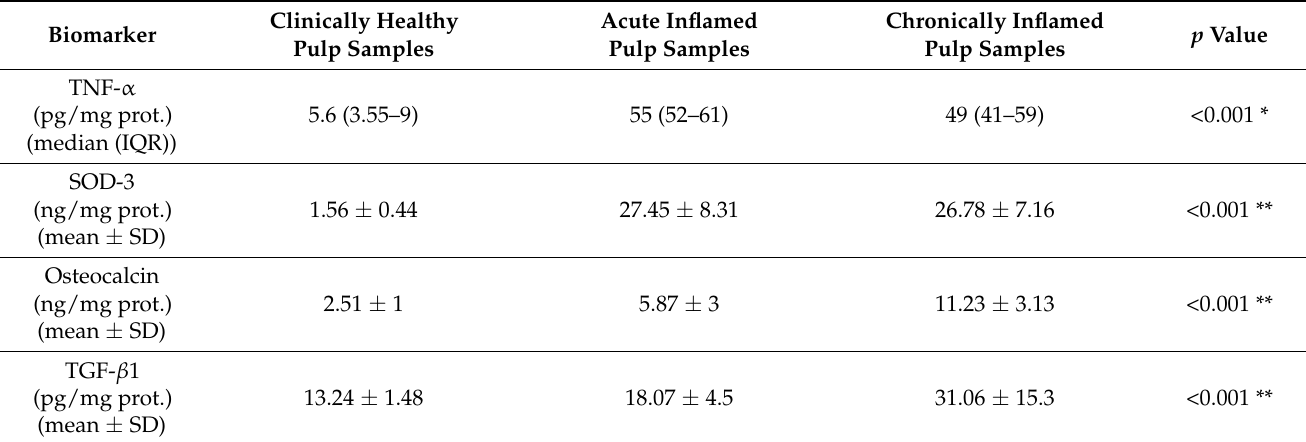
Table 1. Protein expression of biomarkers in the control and experimental groups.